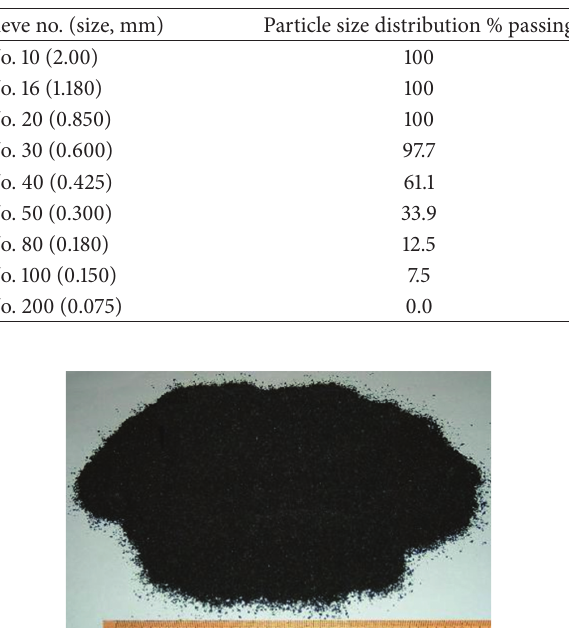
Table 1: Properties of base binder grade 80/100 penetration. Table 2: Sieve analysis of tyre rubber.